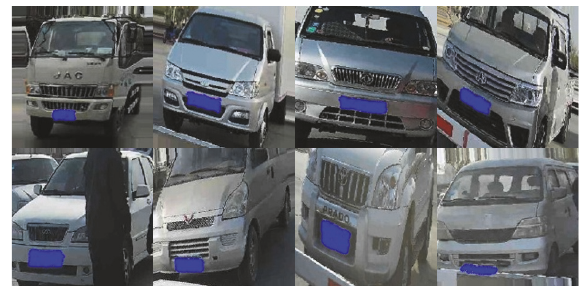
Table 5: Classification precision, recall, and f1-score of pretrained CNNs based on original dataset.